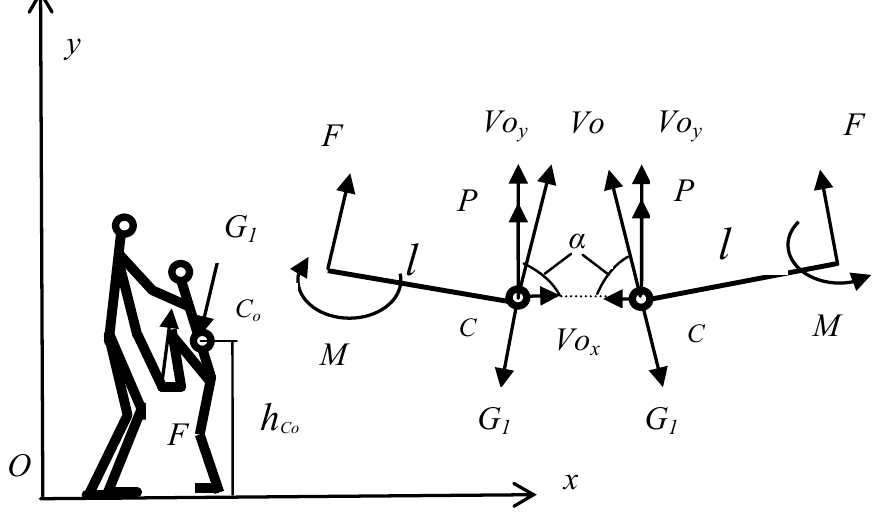
Fig.1. Calculated schema for determination of initial reasonable characteristics of throw